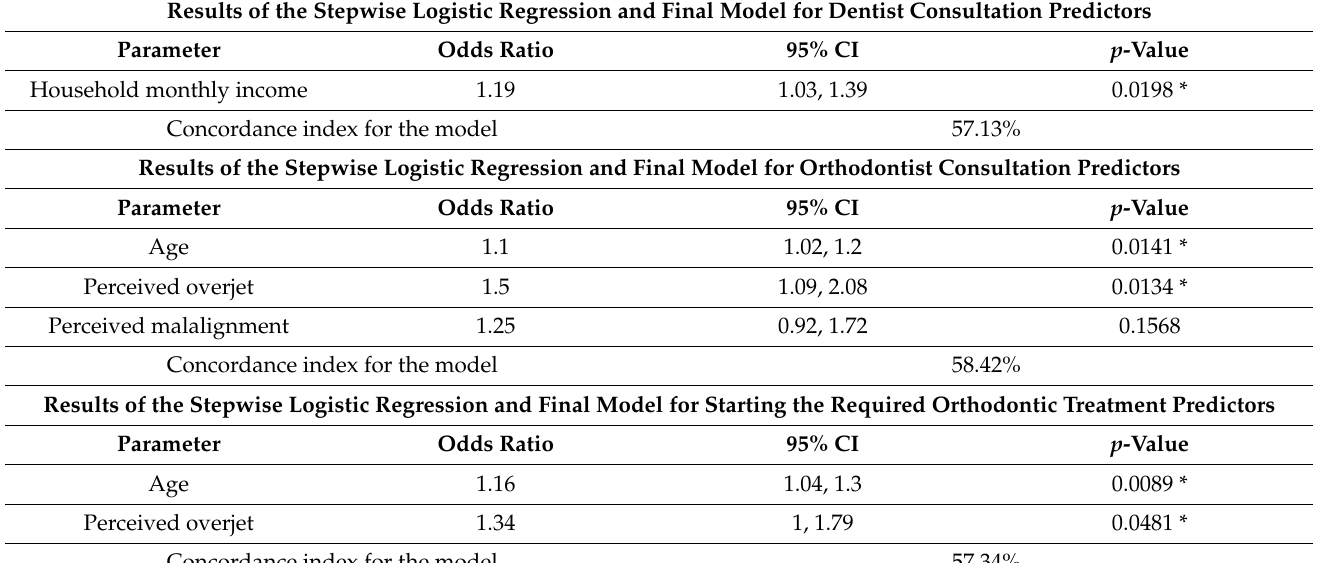
Table 5. Stepwise logistic